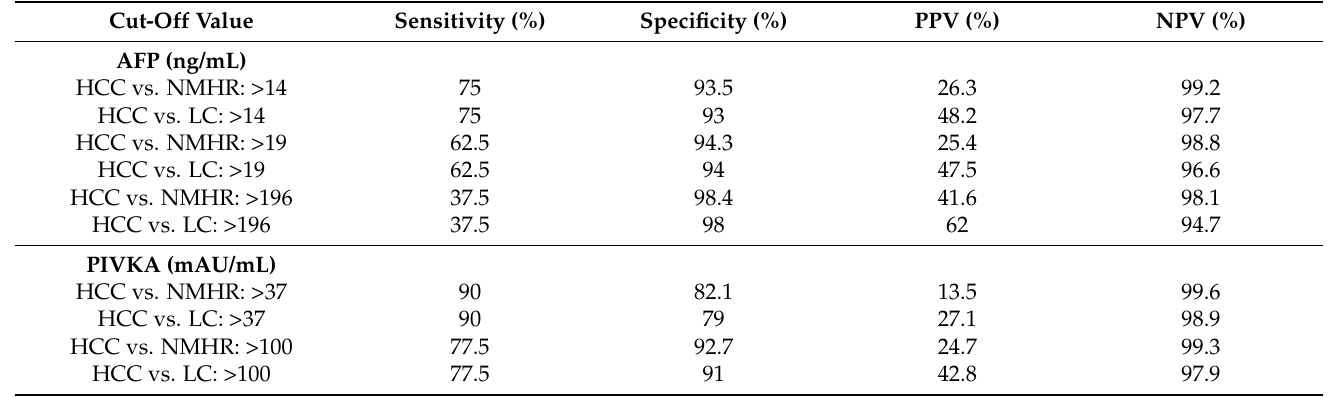
Figure 2. Receiver operating characteristic curves compare PIVKA, AFP, and both in patients with HCC vs. those with liver cirrhosis (LC). The area under the receiver operating characteristic curve was 0.898, 95% CI, 0.835 to 0.943, p < 0.0001 for PIVKA, 0.865, 95% CI, 0.797 to 0.917, p < 0.0001 for AFP, and 0.904, 95% CI, 0.842 to 0.947, p < 0.0001 for the combined AFP and PIVKA. p = 0.5121 for AFP vs. PIVKA-II, p = 0.2538 for Combination vs. PIVKA-II, and p = 0.4130 for Combination vs. AFP. The best cut-off values in differentiating HCC and NMHR for PIVKA-II and AFP were 36.7 mAU/mL (Youden index J: 0.7211) and 14.2 ng/mL (Youden index J: 0.6850), respectively. The sensitivity and specificity at these cutoff values were 90% and 82.1%, respectively, for PIVKA-II and 75% and 93.5%, respectively, for AFP. Table 4 shows the sensitivity, specificity, positive predictive value (PPV), and negative predictive value (NPV) for different cut-off values differentiating HCC from NMHR and liver cirrhosis. Table 4. Sensitivity, specificity, PPV, and NPV for different cut-off values of tumour markers in distinguishing hepatocellular carcinoma from NMHR and liver